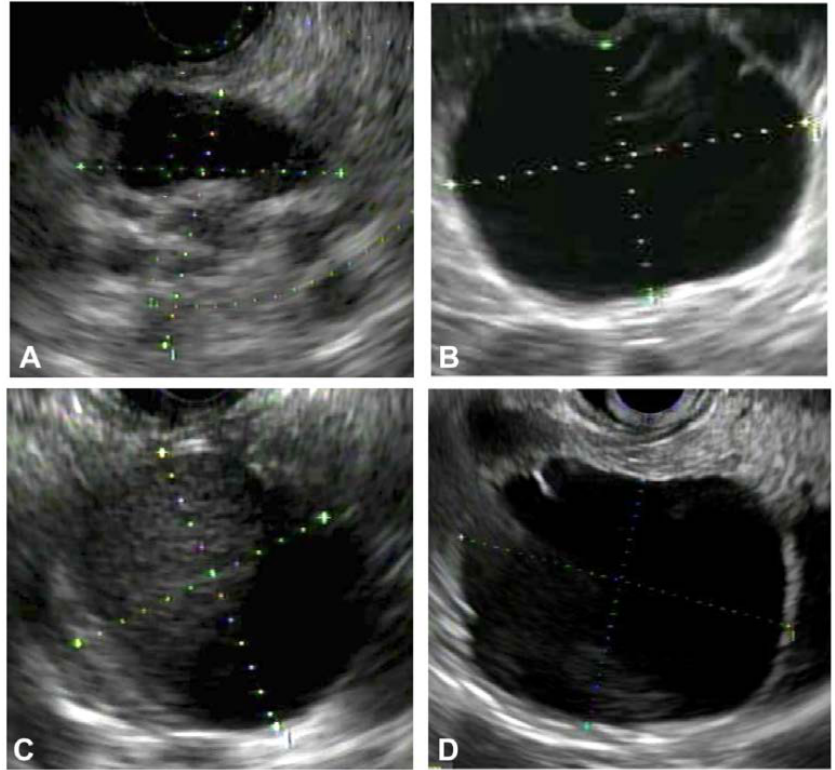
Figure 2. EUS appearance of various pancreatic cystic lesions. ( A ) 2.5 cm cyst with mural nodularity (11 mm); diagnosis: intraductal papillary mucinous neoplasm with high-grade dysplasia. ( B ) 6 cm thin-walled cyst; diagnosis: mucinous neoplasm with low-grade dysplasia. ( C ) 3.2 cm cyst with intracystic debris and wall thickness; diagnosis: pseudocyst. ( D ) 4.6 cm unilocular cyst; diagnosis: serous cystadenoma.